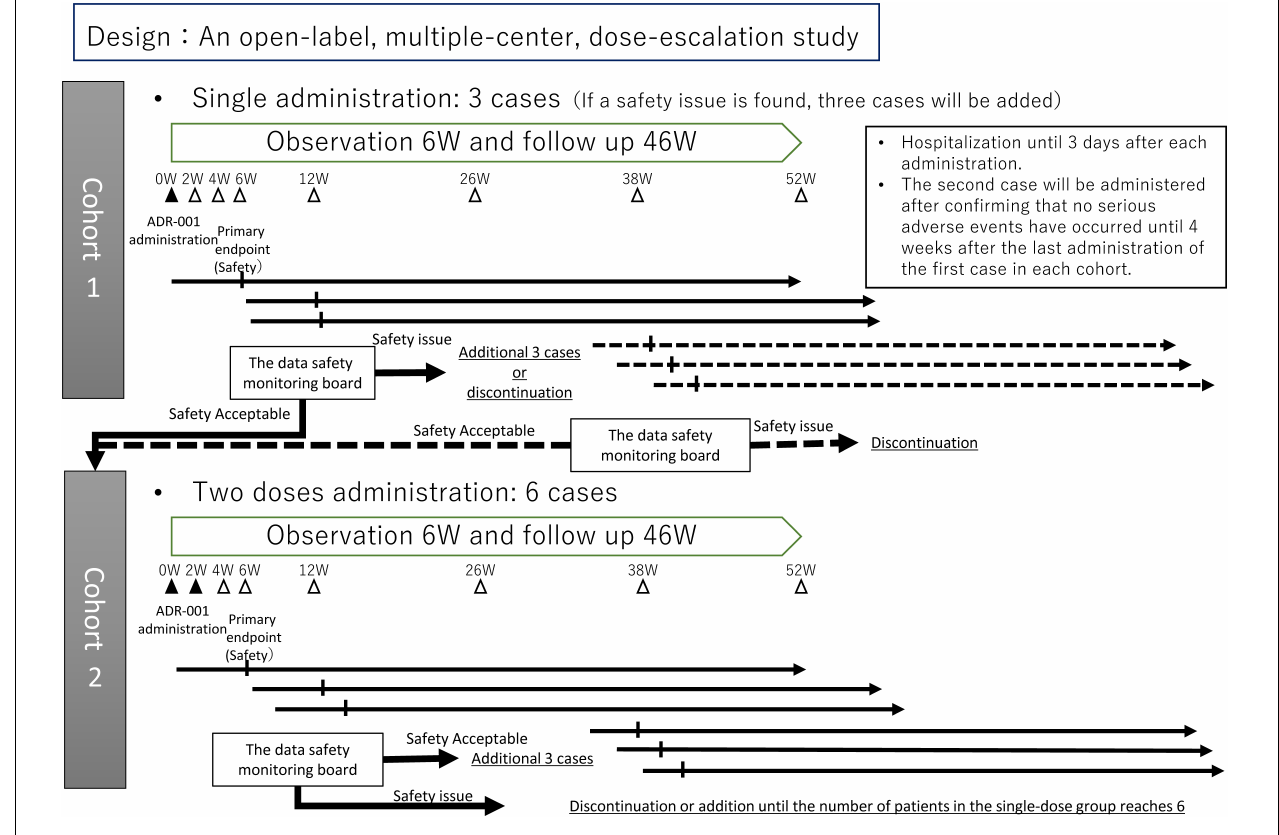
FIGURE 1 | Outline of the study. The study will start with cohort 1, and after assessment, then move to cohort